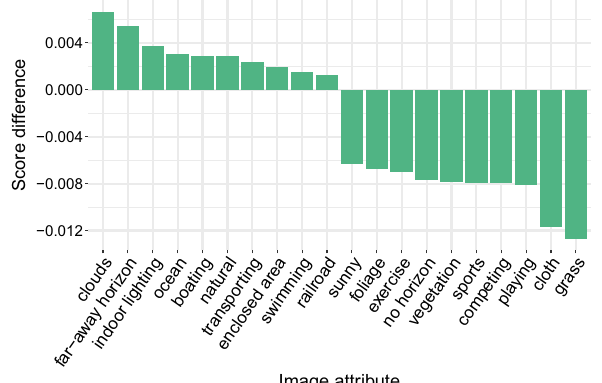
Figure 4. The largest differences in image attribute scores after limiting Flickr user contributions. To calculate the difference, a single image per user per day per grid cell was randomly selected ten times and the mean attribute scores were calculated per grid cell. The median difference versus the unfiltered dataset is shown here with summary statistics available in Supplementary Table S5 online. Drawn using R 3.6.3 (https:// www.r- proje ct. org/) and the ggplot2 3.3.5 (https:// ggplo t2. tidyv erse. org)